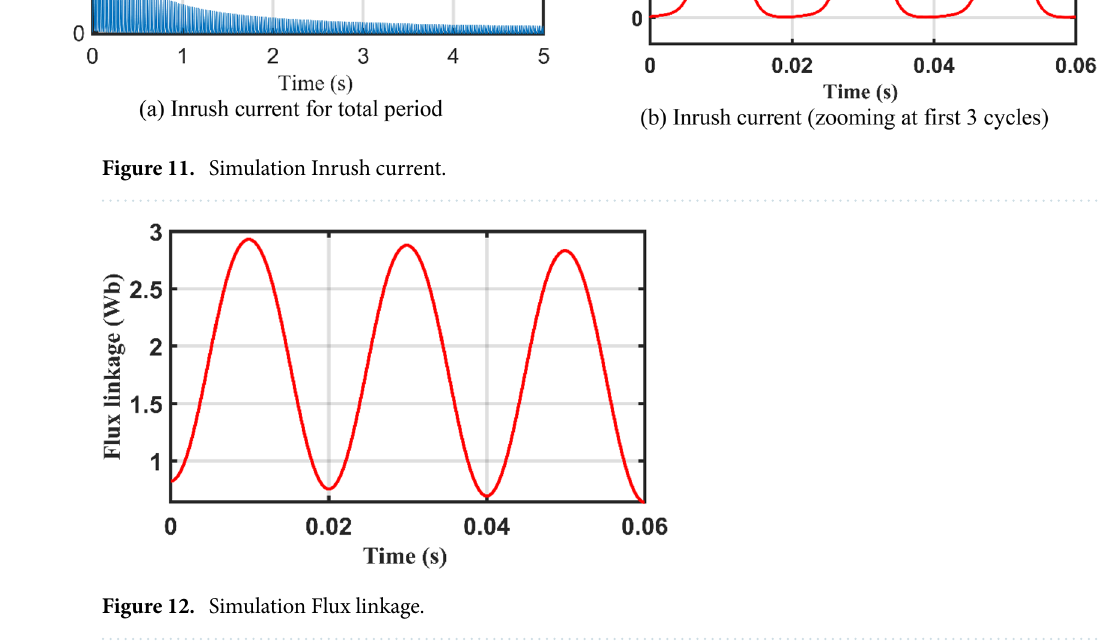
Figure 12. Simulation Flux linkage.